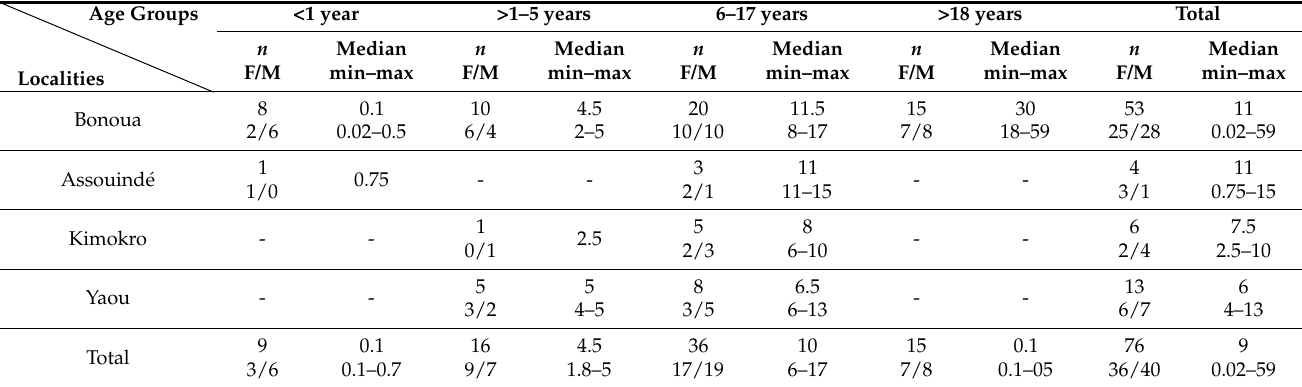
Table 1. Demographic characteristics of enrolled